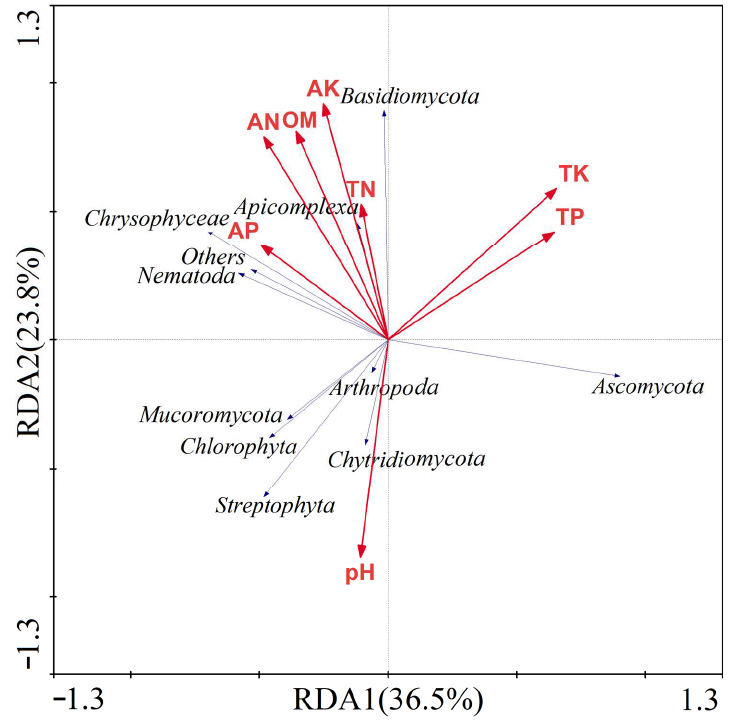
Figure 6. RDA between the dominant eukaryotic microorganisms and soil properties.